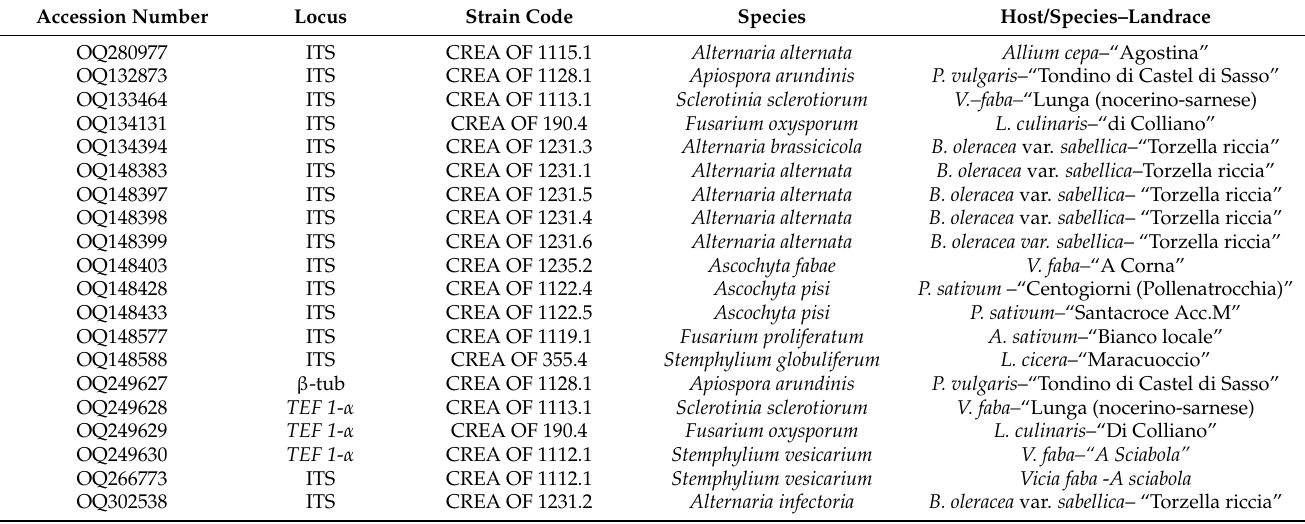
Table 2. GenBank records of CREA OF isolates.